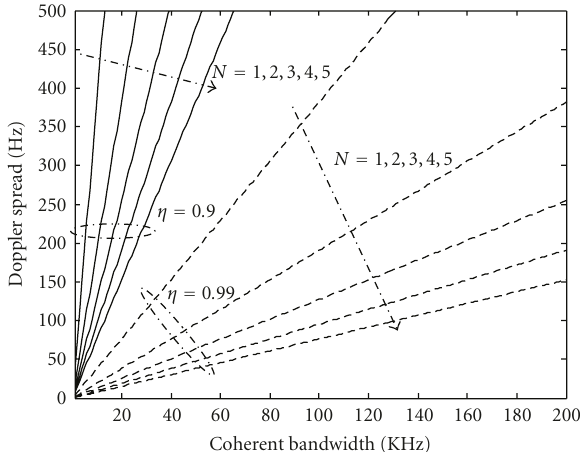
Figure 4: Minimal Doppler spread for security, Rayleigh fading; N =